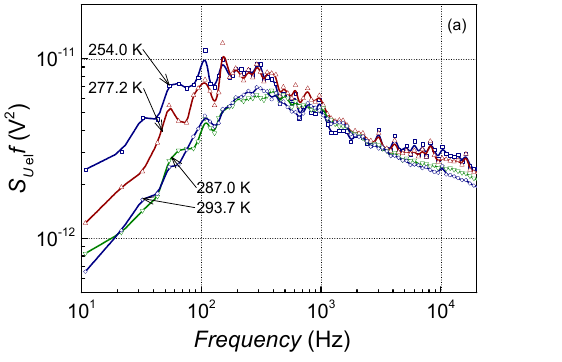
Figure 10. Lorentzian-type electrical noise spectra multiplied by frequency at 0.01 mA forward current ( a ) and characteristic time dependency on temperature ( b ) for the generation and recombination processes observed from 205 K to 294 K in sample No. 9.